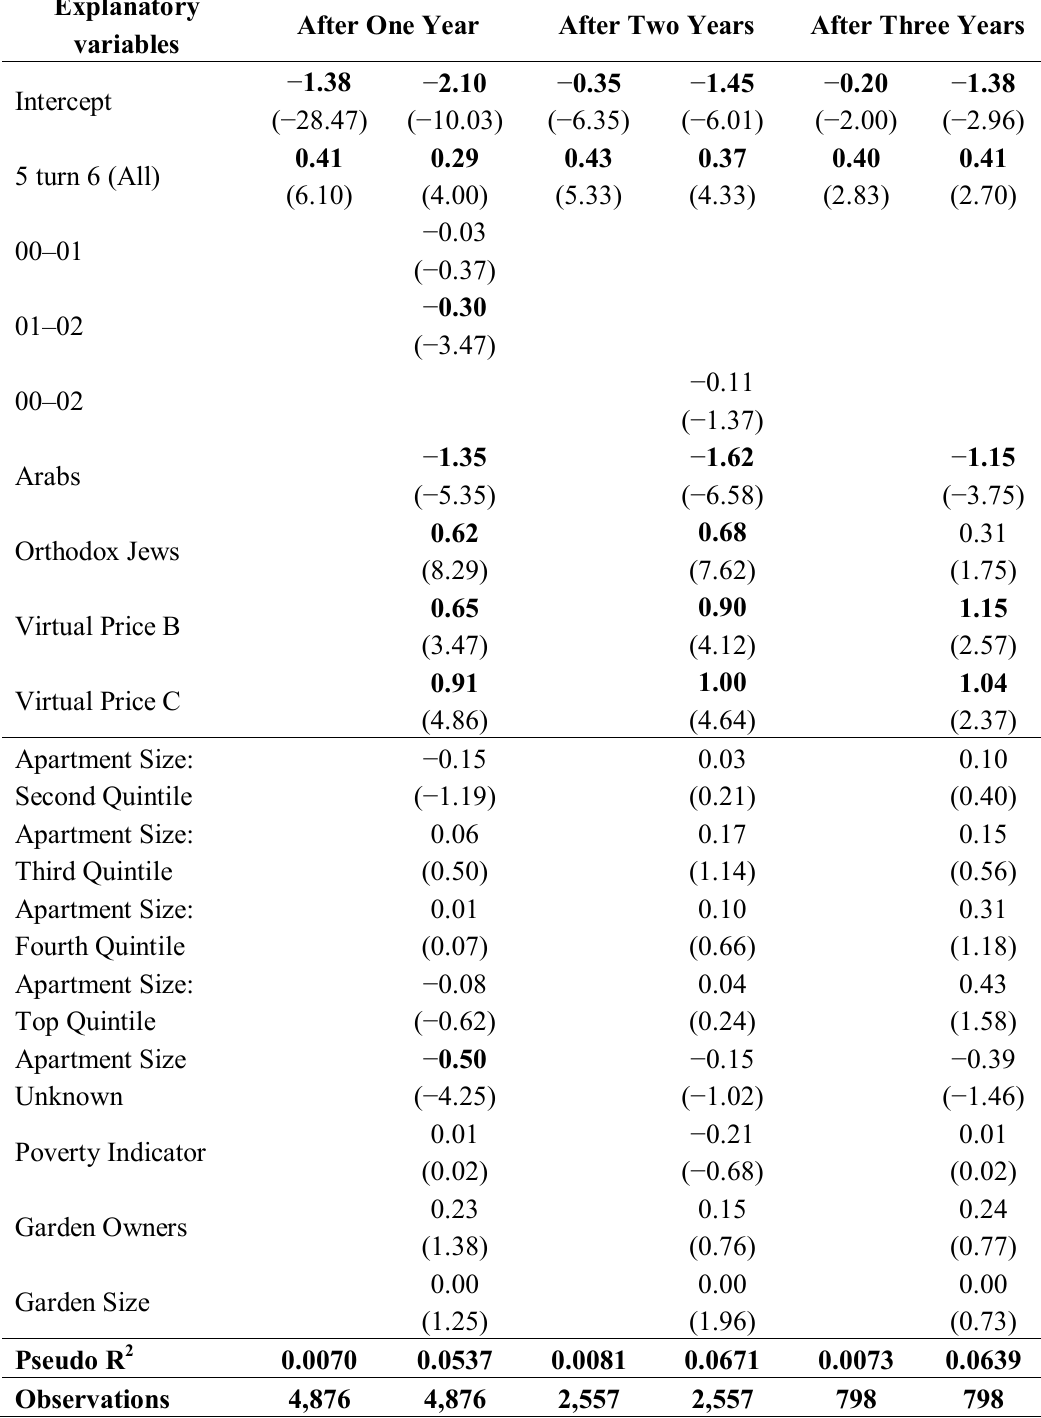
Table 9. Effect of information costs on take-up rates: Logit estimation. (Dependent variable: reporting status in year